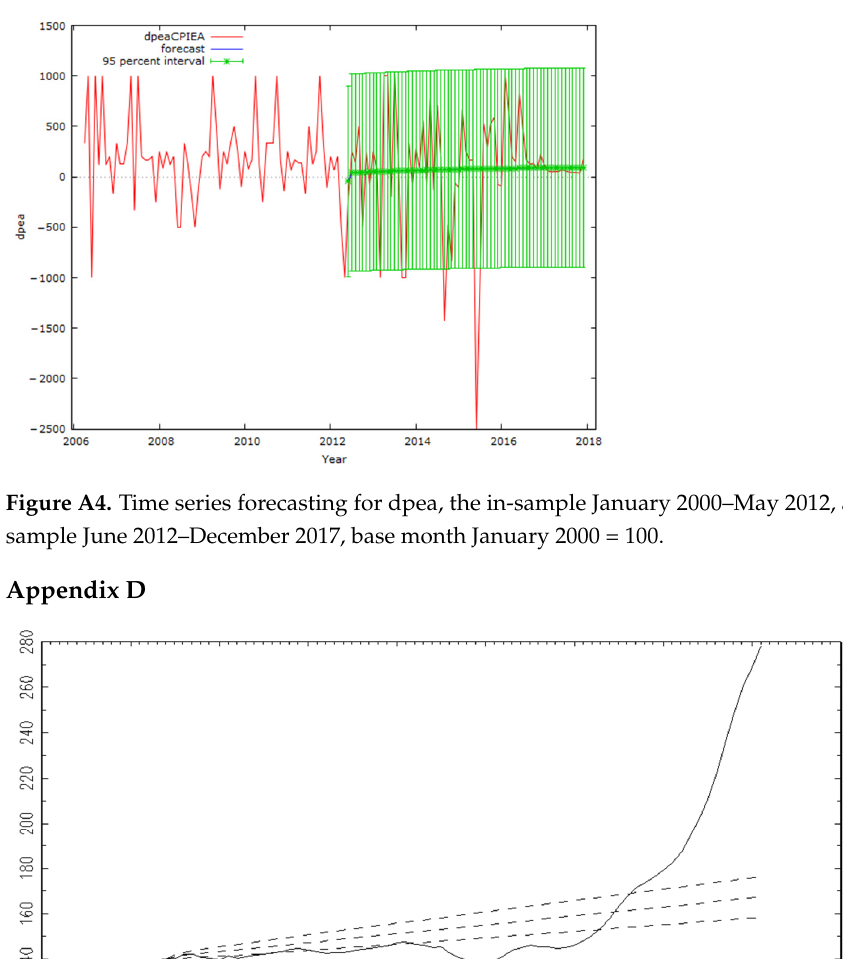
Figure A3. Time series forecasting for CPIEA, the in-sample January 2000–May 2012, and the out-